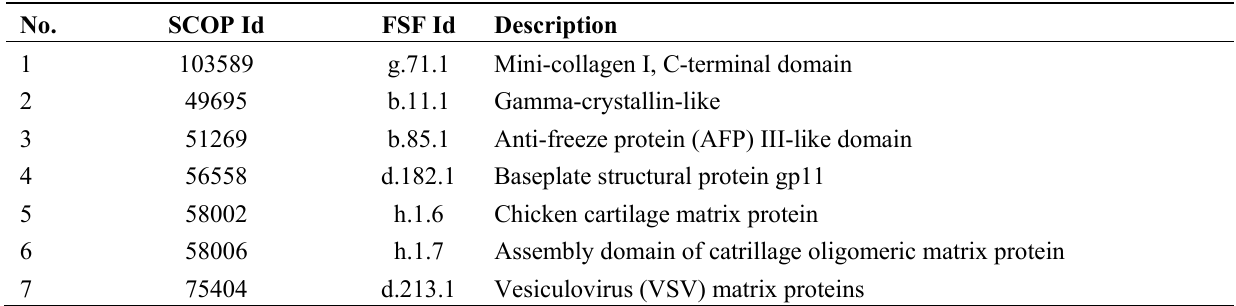
Table S4. Names and description of FSF domains corresponding to subcategory s tructural proteins in the main category General .